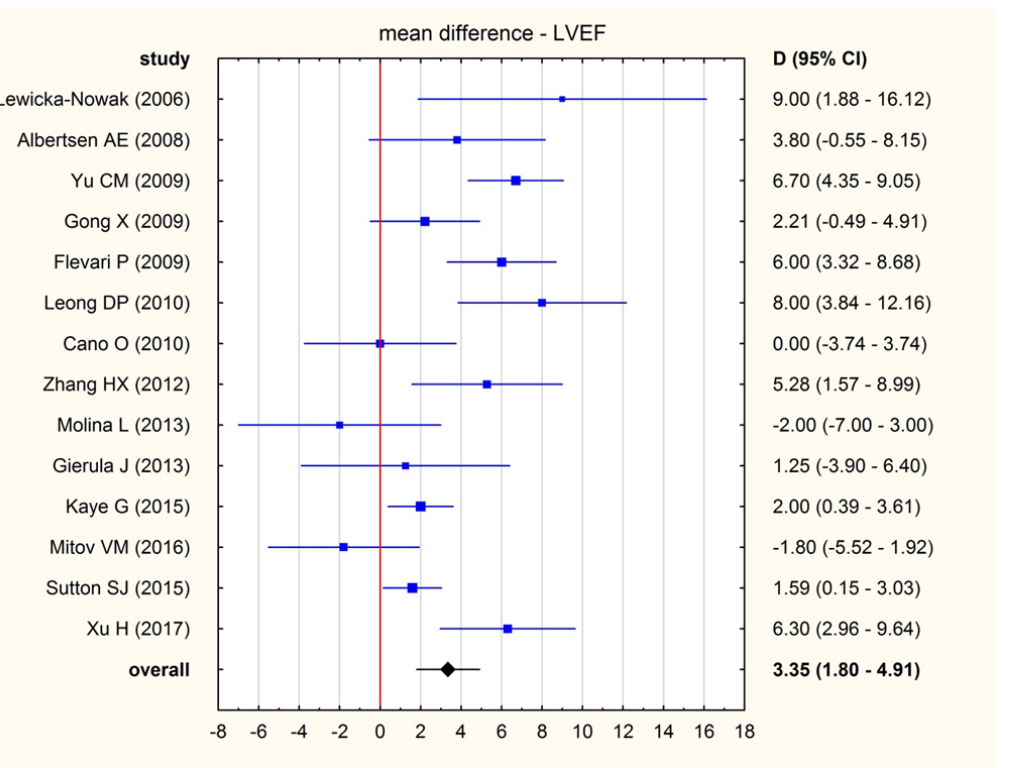
Figure 3. Forrest plot illustrating pooled mean difference (MD) with a 95% confidence interval (CI) of LVEF (%) [25–38].